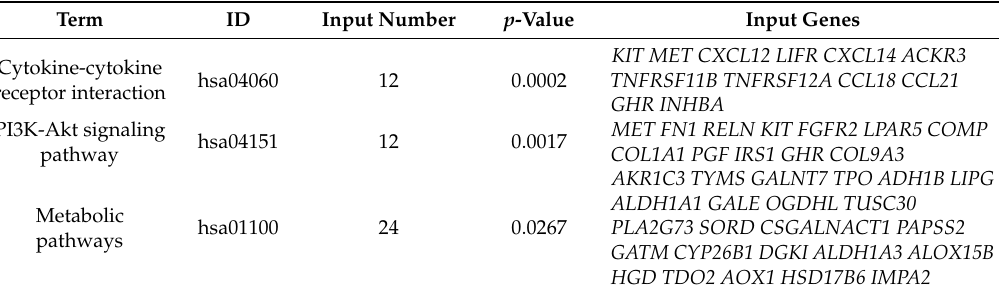
Table 4. Kyoto Encyclopedia of Genes and Genomes (KEGG) pathway analysis of DEGs associated with